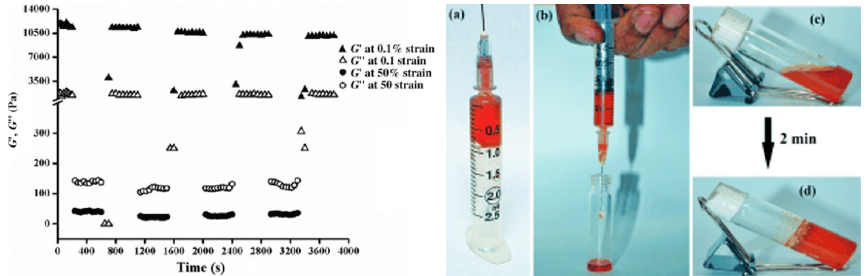
Figure 5. ( Left ) Time-dependent repetitive cycle of step-strain analysis of the hydrogel–AgNP soft nanocomposite with a 0.6 % w/v gelator concentration. ( Right ) Photographs of ( a ) AgNP-incorporated hydrogel in a syringe; ( b ) nanocomposite gel flowing through the needle of a syringe; ( c ) solution of AgNP-1 composite after syringe processing; and ( d ) AgNP-including hydrogel that is re-formed after shear thinning at room temperature for 2 min. Image adapted with permission from reference [45].